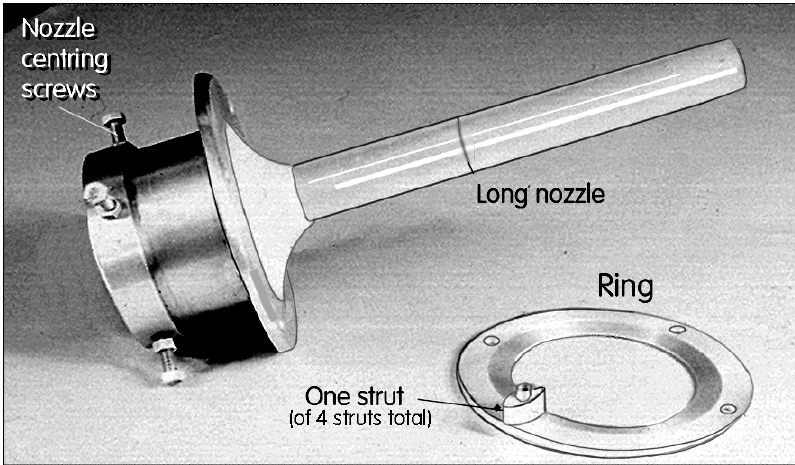
Figure 7. Photograph of the long central nozzle (inner part M, cf. Figure 4). It defines the other annular wall of the radial inflow into the mixing tube.